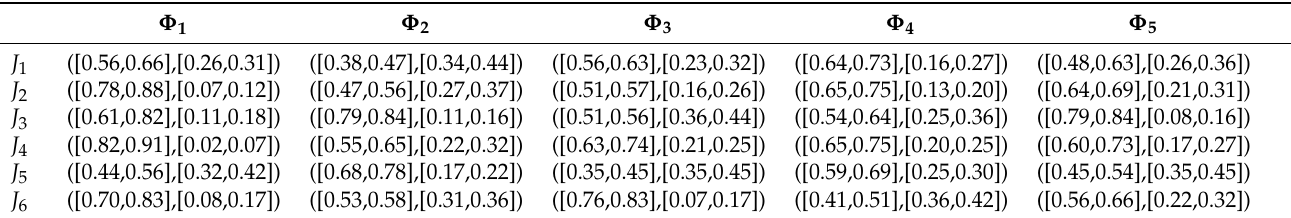
Table 1. IVIF decision matrix.